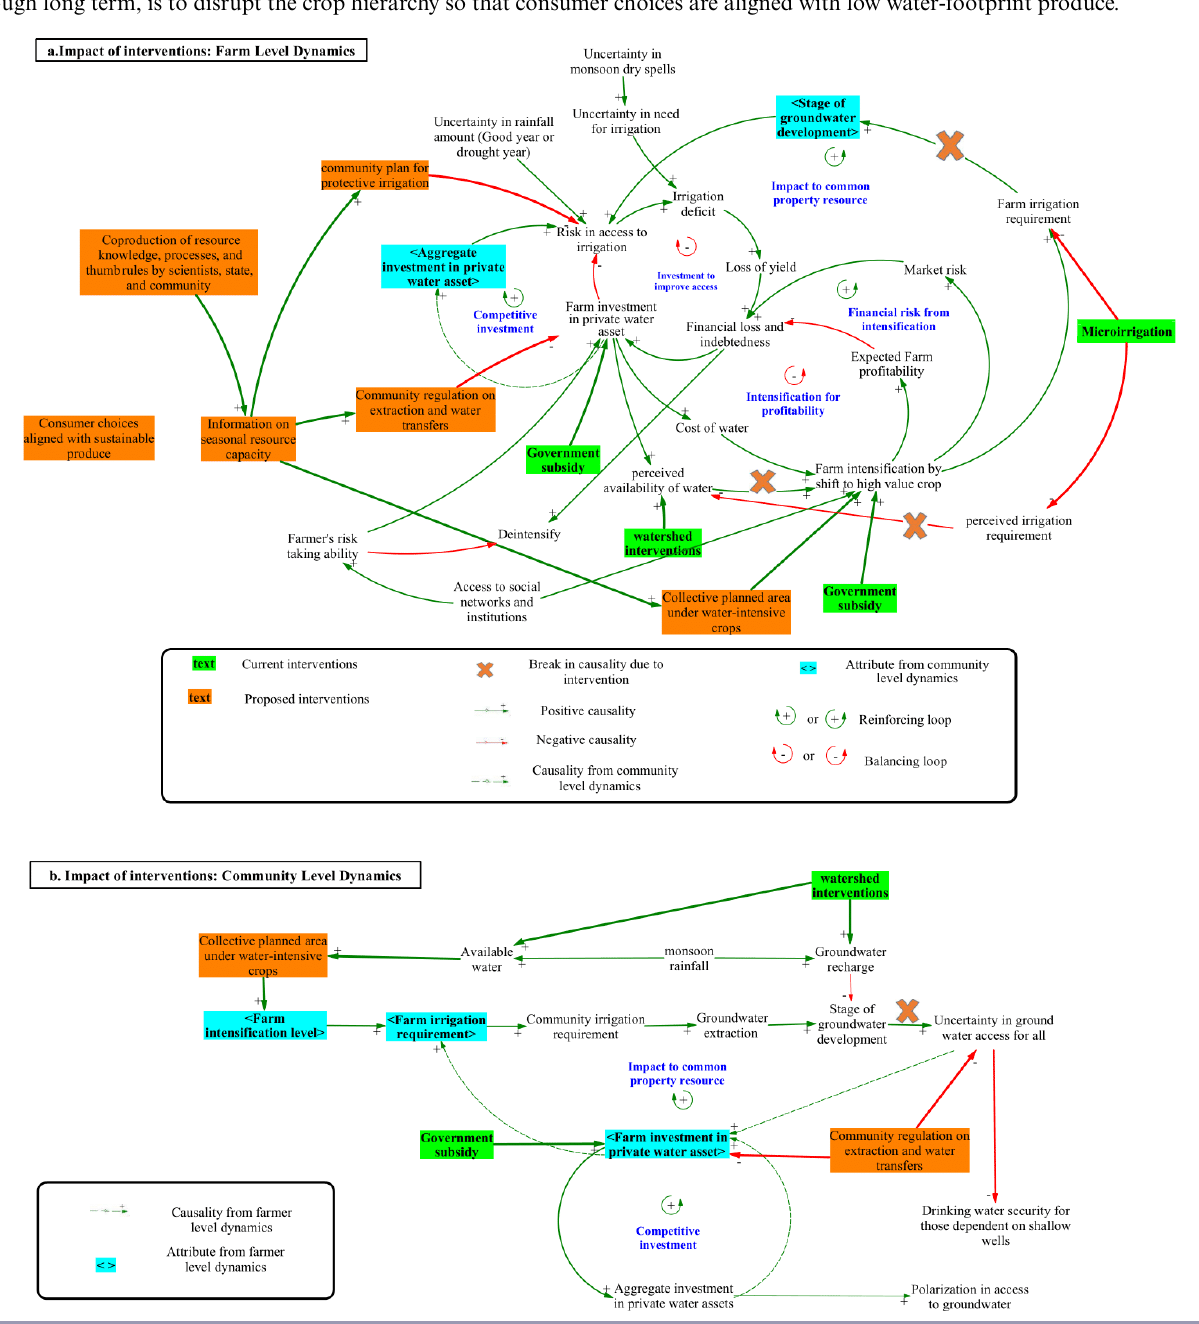
Fig. 7 . What will stop the vicious cycles? Leverage points. Current interventions by the state are low leverage points. Watershed interventions increase groundwater recharge and promotion of microirrigation enhances water-use efficiency. But the perception of enhanced water availability due to these interventions continues to drive the cycle of intensification beyond sustainable levels. Government subsidies for new farm-ponds and orchards further contribute to this. Higher leverage points are those that will limit intensification and investments to a level within the social-ecological thresholds of the SES. Collective planning of seasonal intensification level based on a sound estimate of available water will reduce risk of crop failures due to irrigation shortage and build resilience to monsoon variability. This, as shown, will break the vicious cycle of impact to common property resource. A community plan for setting aside water for protective irrigation will reduce uncertainty during monsoon dry spells. Community regulation will stop the competitive investment and intensification for profitability loops, reduce failures and variability in returns. These interventions require coproduction of local science of water by scientists, state, and the community. An even higher leverage point, though long term, is to disrupt the crop hierarchy so that consumer choices are aligned with low water-footprint